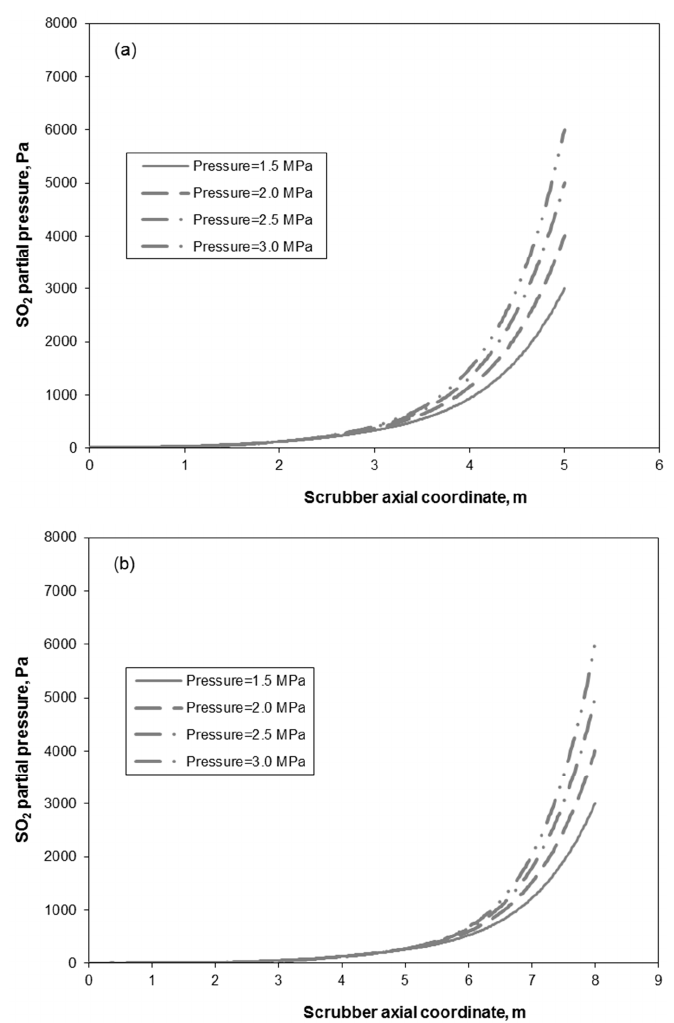
Figure 11. Steady-state axial profiles of SO 2 partial pressure at different values of scrubber pressure (Packed-bed column with Raschig super-Rings, Packed-bed column inclination angle = 15 deg): ( a ) H = 5 m; ( b ) H = 8 m. Table 2. Parameters used in simulations.